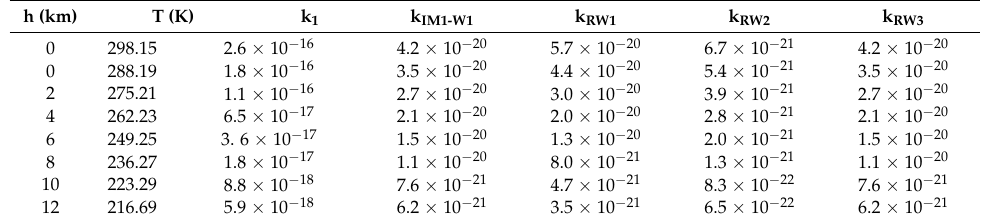
Table 5. Rate constants (in cm 3 molecule − 1 s − 1 ) for the CH 2 O + ClO reaction with one water molecule at different heights (h).